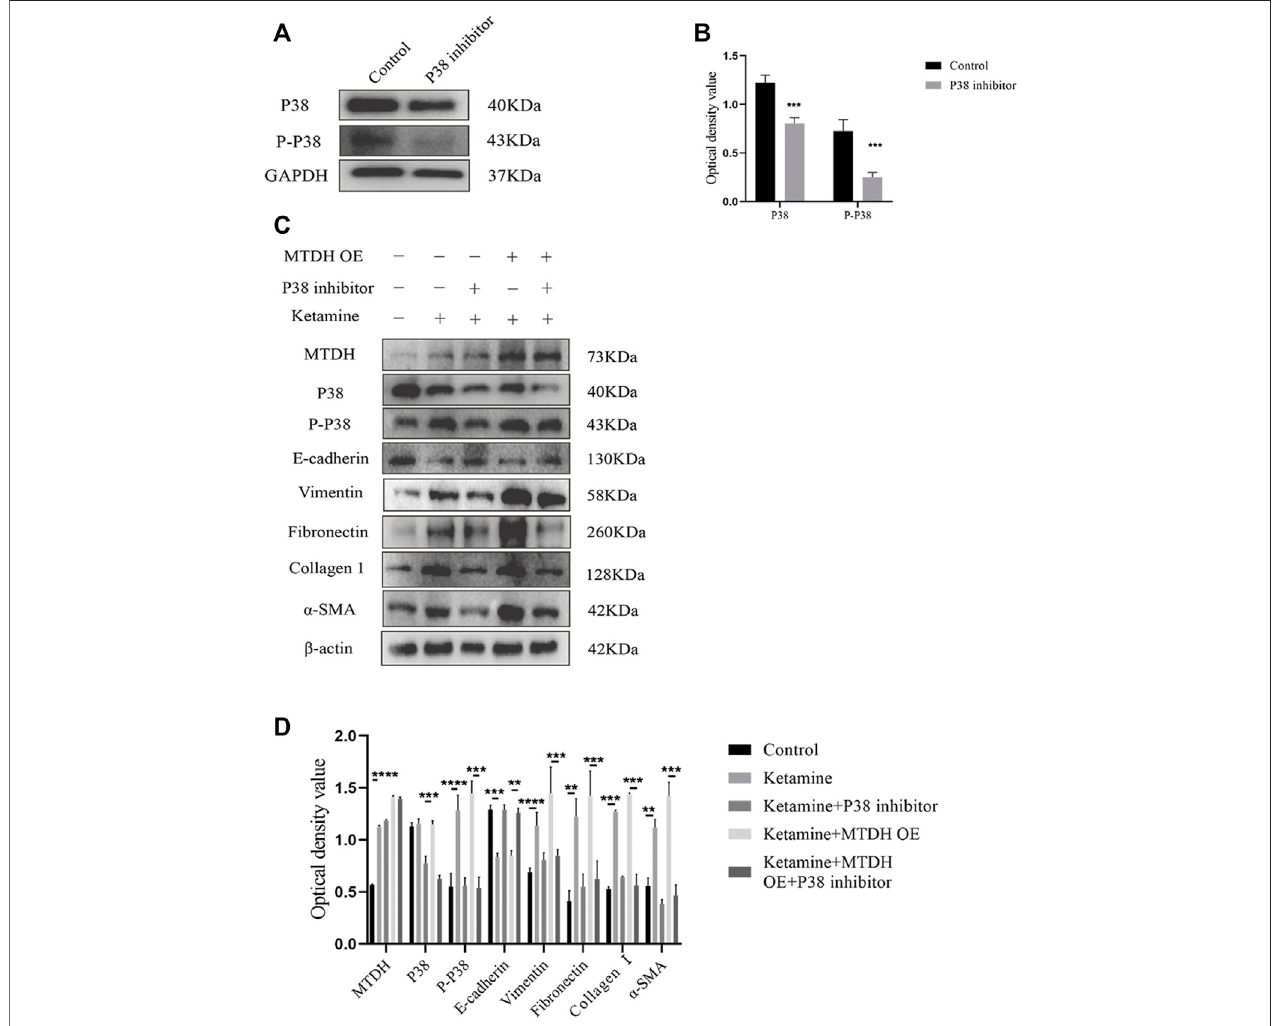
FIGURE 7 | The in fl uence of P38 inhibitor SB203580 on the regulation of MTDH in SV-HUC-1 cells. (A) Representative bands from Western blot analyses of the levels of the P38 and P-P38 protein in SV-HUC-1 cells after treatment with SB203580. (B) Relative levels of the P38 and P-P38 protein compared to GAPDH. *** p < 0.001 compared withcontrol group, ** p < 0.01 compared withcontrol group. (C) Representativebands from Western blotanalysesofthelevels oftheMTDH, P38,and P-P38, E-cadherin, vimentin, fi bronectin, collagen Ⅰ , α -SMA protein in SV-HUC-1 cells after treatment with ketamine, ketamine and SB203580, ketamine and MTDH overexpression plasmid, ketamine and MTDH overexpression plasmid and SB203580 (treated for 48 h). (D) Relative levels of the MTDH, P38, and P-P38, E-cadherin, vimentin, fi bronectin, collagen Ⅰ , α -SMA protein compared to β -actin. ** p < 0.01; *** p < 0.001; **** p < 0.0001. N (cid:1) 3.